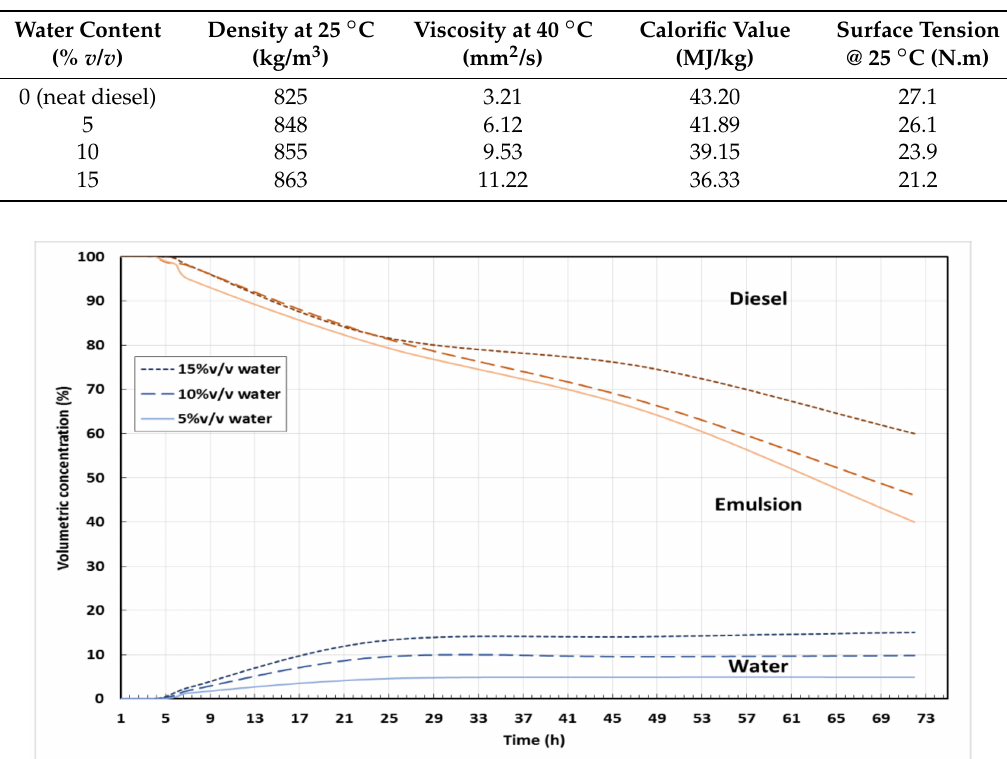
Figure 1. All samples were stable for the first 4 h, and then exhibited some de-emulsification after 5 h. After 3 days all samples showed complete separation of the emulsions, with the samples that contained the highest concentrations of water resulting in the most significant